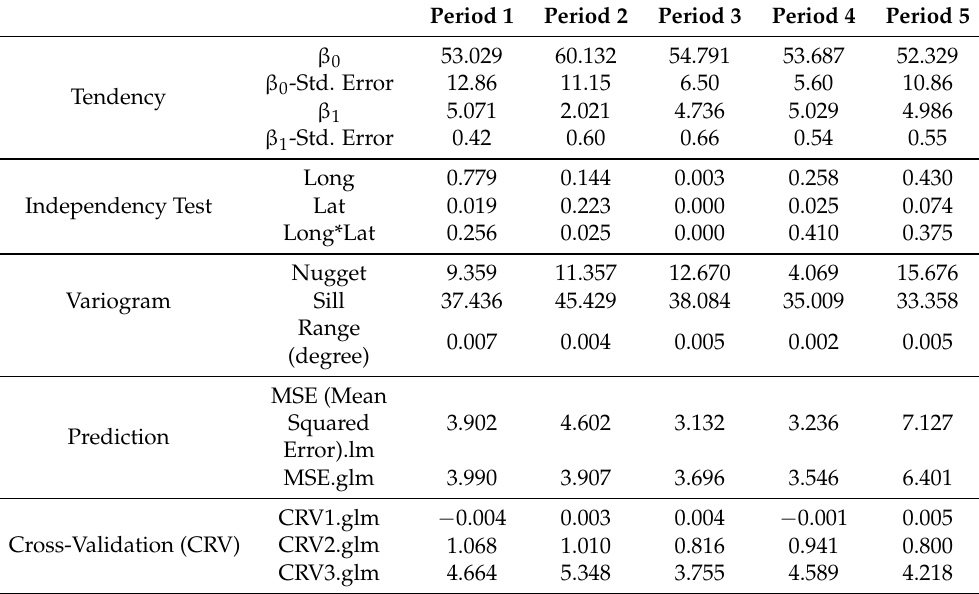
Table 4. Summary of the spatial-temporal analysis of noise